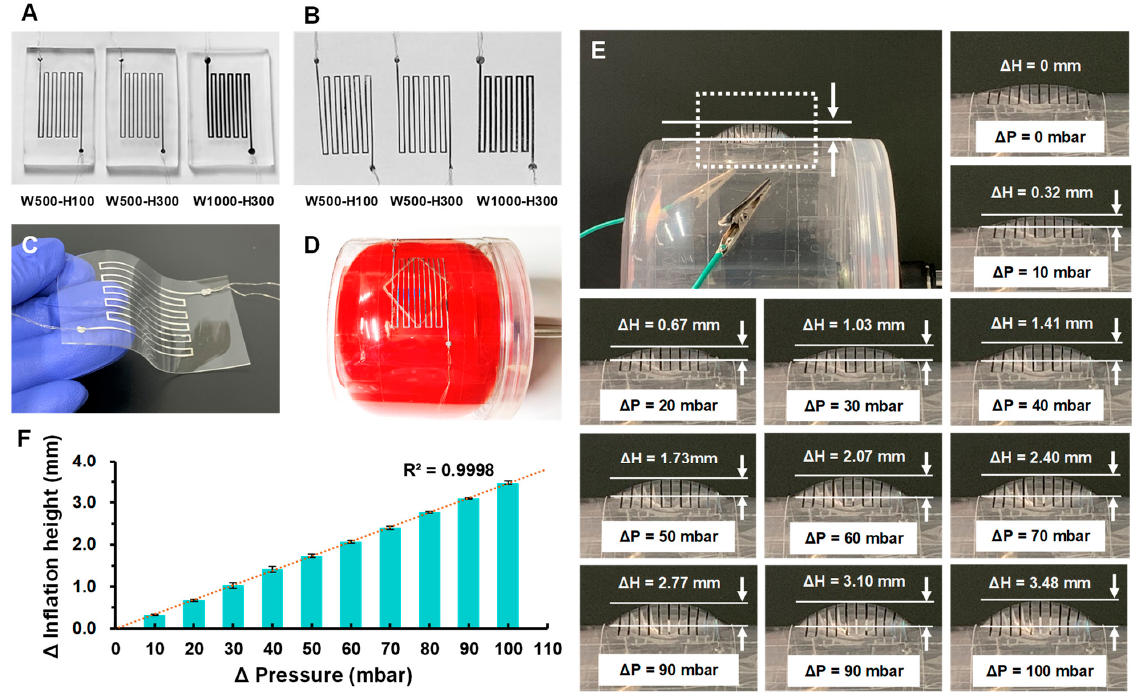
Figure 3. Solidified Ga structures of three different designs with contact wires ( A ) in the PDMS mold after incubating in a − 20 °C freezer and removing the sealing tape and ( B ) after peeling off from the PDMS molds. Image of ( C ) the final ICP sensor and ( D ) the artificial fontanelle model assembled with the ICP sensor. A red balloon was used for visualization purposes. ( E ) A balloon-in-box fontanelle model assembled with an ICP sensor (W500-H300), showing different inflation heights at different pressure levels. ( F ) Correlation between the applied pressure and the inflation height of the fontanelle model (R 2 = 0.9998).